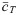
Solutions as a function of total calcium concentration c¯T, with calsequestrin concentration set to zero when the fast dyadic approximation is used.We obtain the same type of structure as expected. The system can be in a monostable state, which is excitatory (low load), in an oscillatory state (intermediate load), or in a bistable state (high loads), where it usually ends in a state of open RyR and depleted SR calcium concentration.